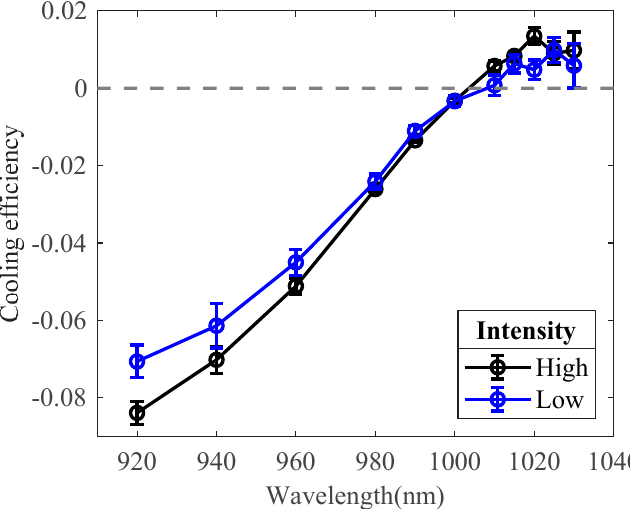
Figure 11. Experimentally determined cooling efficiencies versus wavelength from TLS measure-